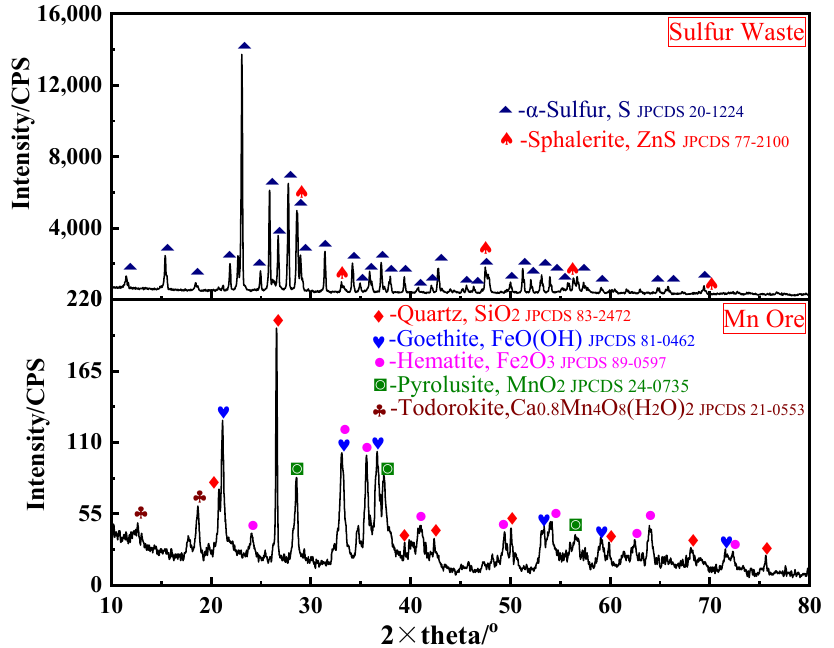
Figure 1. XRD patterns of the sulfur waste and manganese oxide ore.